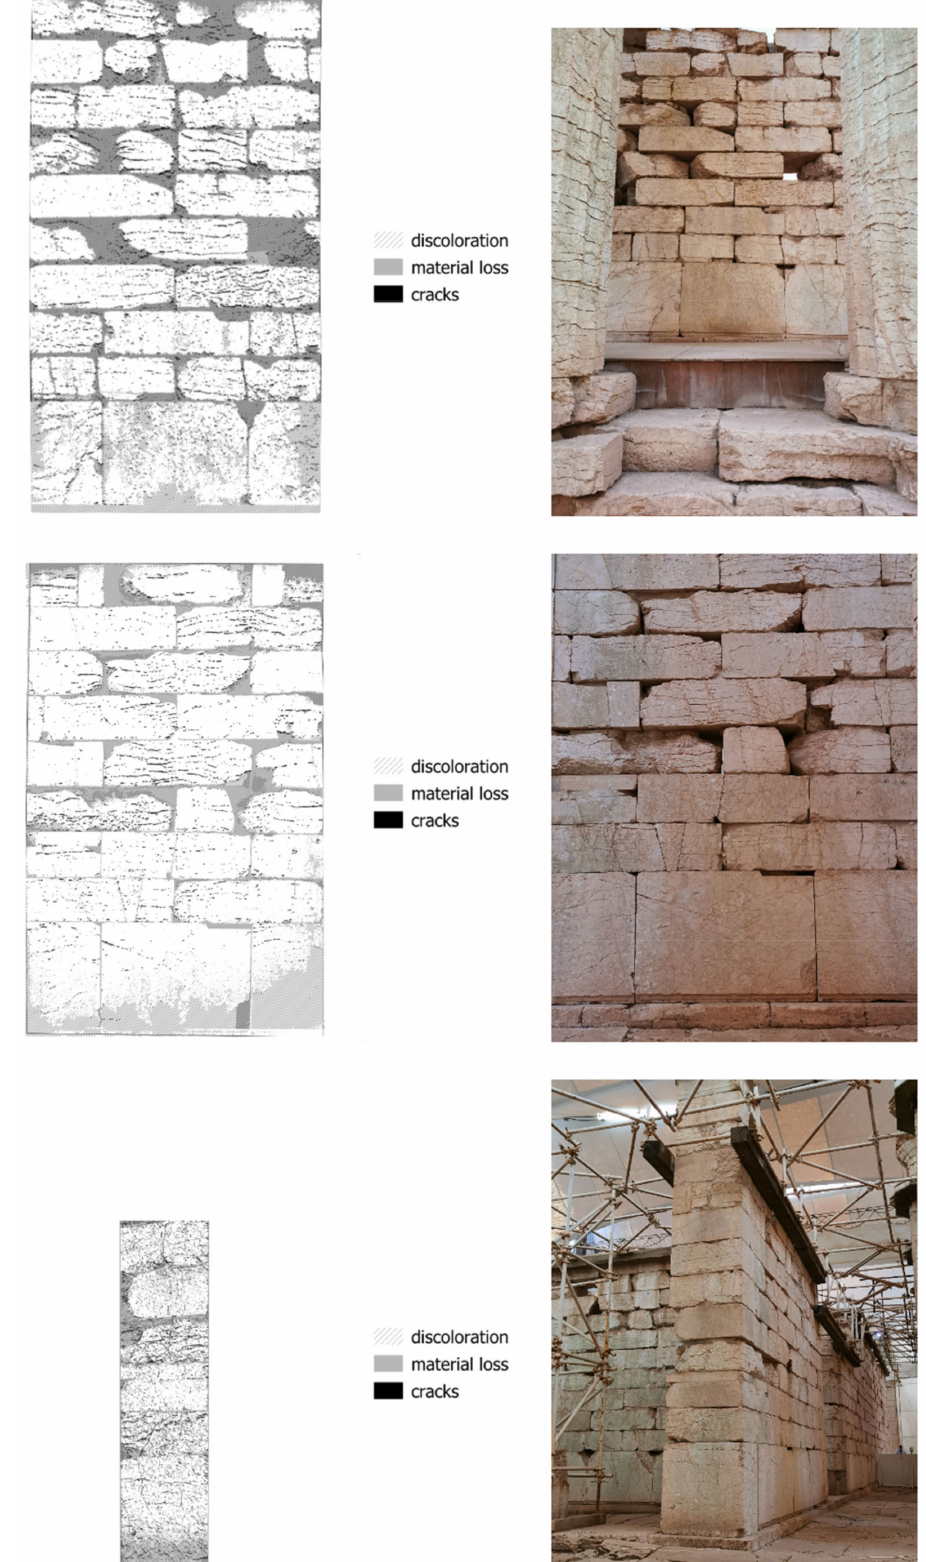
Figure 6. Degradation maps and corresponding images for characteristic areas of walls at the Temple of Apollo